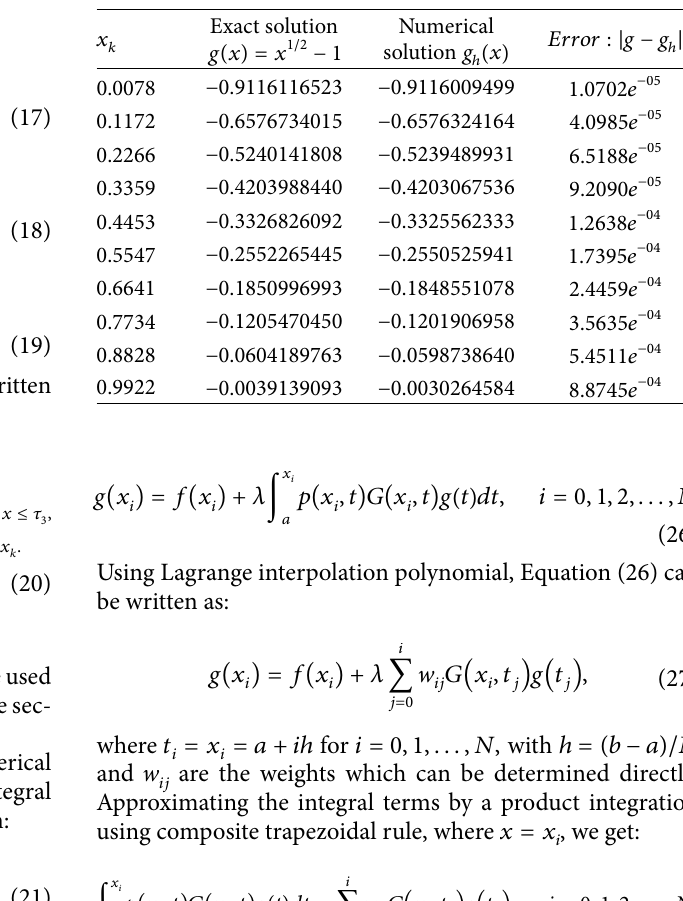
Table 2: The exact and numerical solutions using the Haar wavelet method with 𝑁 = 64